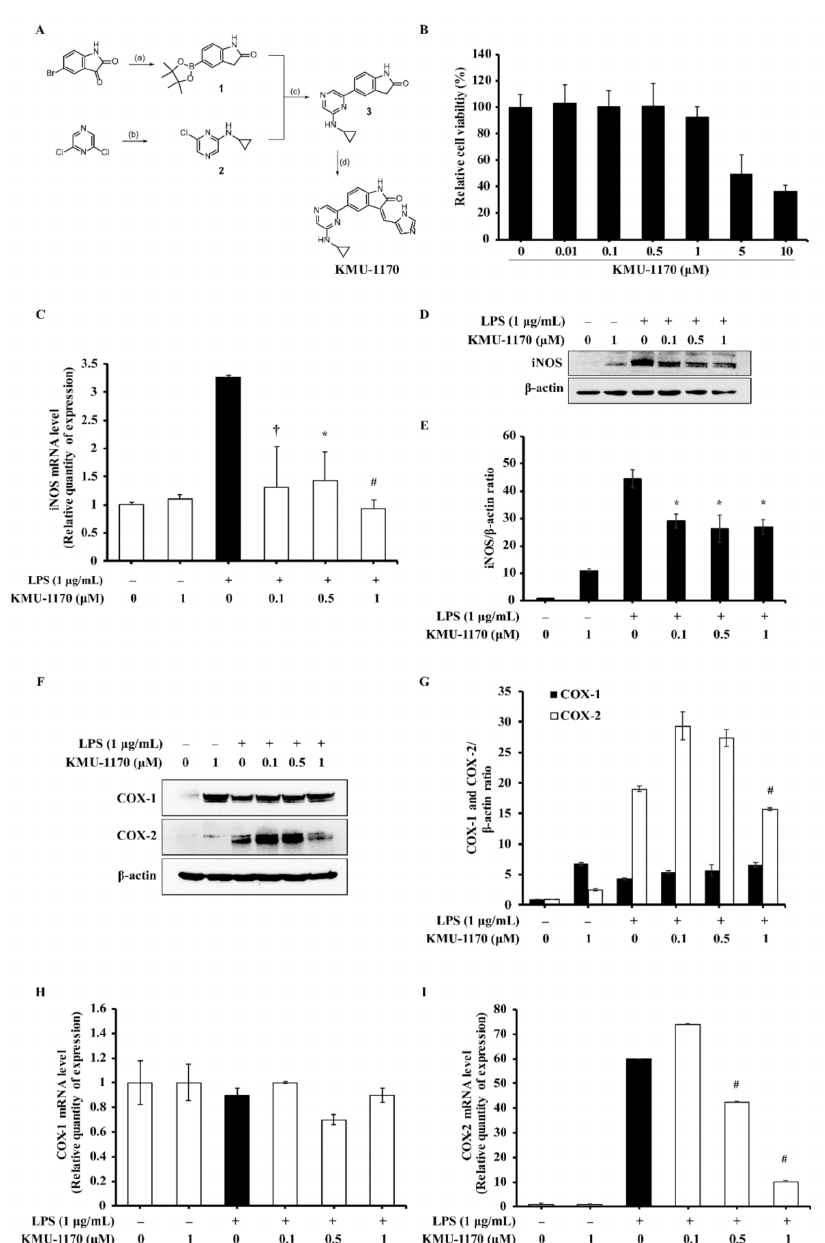
Figure 1. Discovery of KMU-1170, and the effect of KMU-1170 on LPS-induced iNOS and COX-2 in THP-1 cells. ( A ) Synthetic scheme for the synthesis of KMU-1170. Reagents and experimental conditions: (a) (i) NH 2 NH 2 , NaOH, EtOH; (ii) bis (pincholato)diboron, PdCl 2 (dppf), KOAc, 1,4-dioxane: EtOH(1:1.5), microwave; (b) K 2 CO 3 , cyclopropylamine, DMF; (c) PdCl 2 (PPh 3 ) 2 , 2M K 2 CO 3 , 1,4-dioxane: EtOH (1:1.5), microwave; (d) piperidine, 1 H -imidazole-4-carbaldehyde, EtOH, microwave. ( B ) Cytotoxic effect of KMU-1170 in THP-1 cells was performed by XTT assay. Cell were differentiated into macrophages for 24 h using PMA (100 nM), then the cells were treated with different doses of KMU-1170 (0.01, 0.1, 0.5, 1, 5, and 10 µ M) for 24 h. ( C – I ) Cells were treated with LPS (1 µ g/mL) for 6 h after pretreatment with different doses of KMU-470 (0.1, 0.5, and 1 µ M) for 1 h. Total RNA was extracted, and used to determine the mRNA expression levels of iNOS, COX-1, and COX-2 ( C , H , I , respectively). Whole cell lysates were isolated and used to measure the protein expression levels of iNOS and β -actin by Western blot analysis ( D ). Image-J software was used to analyze the relative optical density of the iNOS band ( E ). Whole cell lysates were isolated and used to measure the protein expression levels of COX-1, COX-2, and β -actin by Western blot analysis ( F ). Image-J software was used to analyze the relative optical density of the COX-1 and Cox-2 band ( G ). † p < 0.05, * p < 0.01, and # p < 0.001 compared to LPS